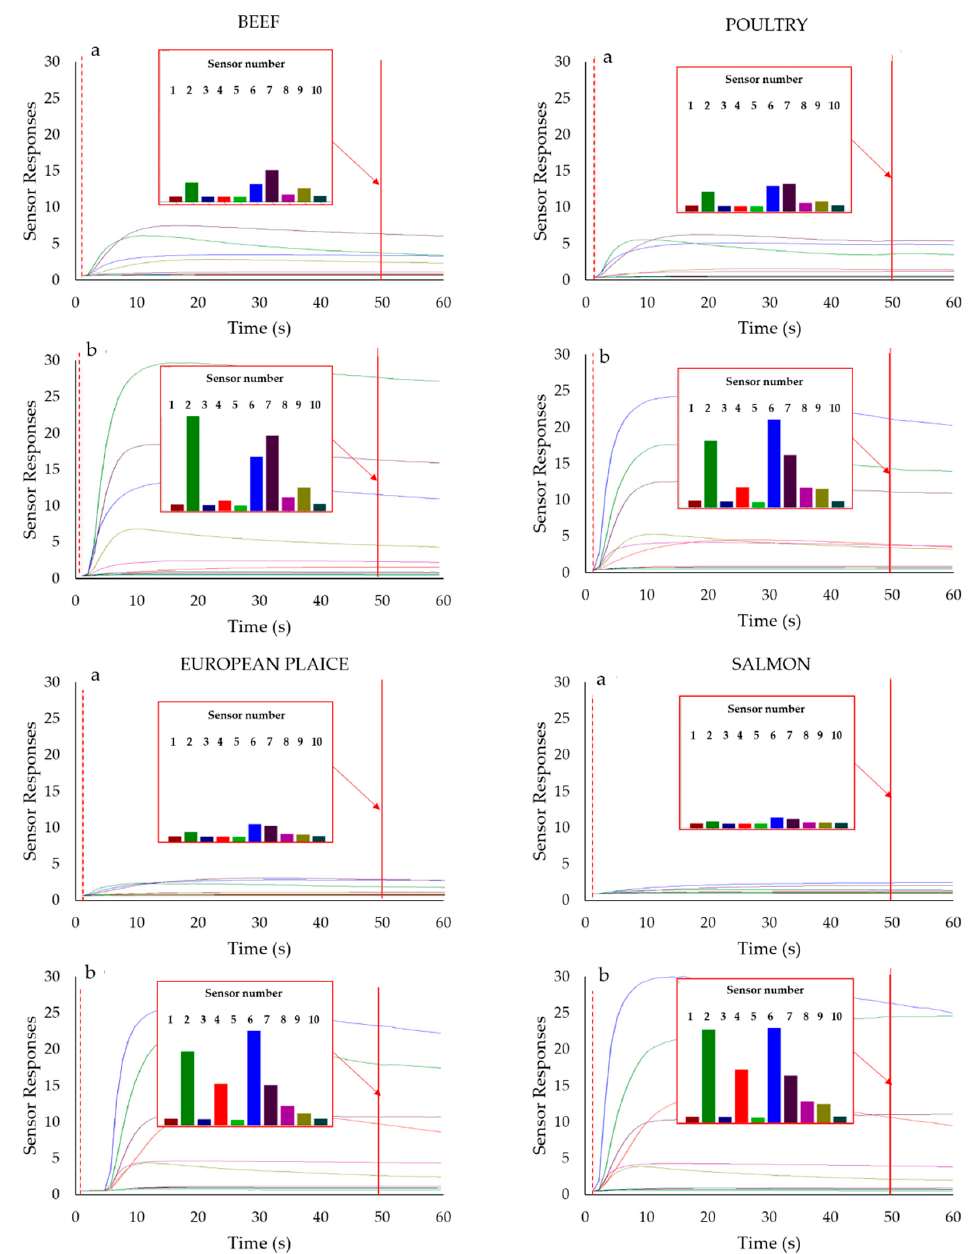
Figure 3. Metal oxide semiconductor sensor responses for meat and fish samples collected the first day of sampling ( a ) and at the expiration date of the product ( b ). The histograms represent the 10 sensor responses after 50 s of sampling. Each bar colour corresponds to a sensor.